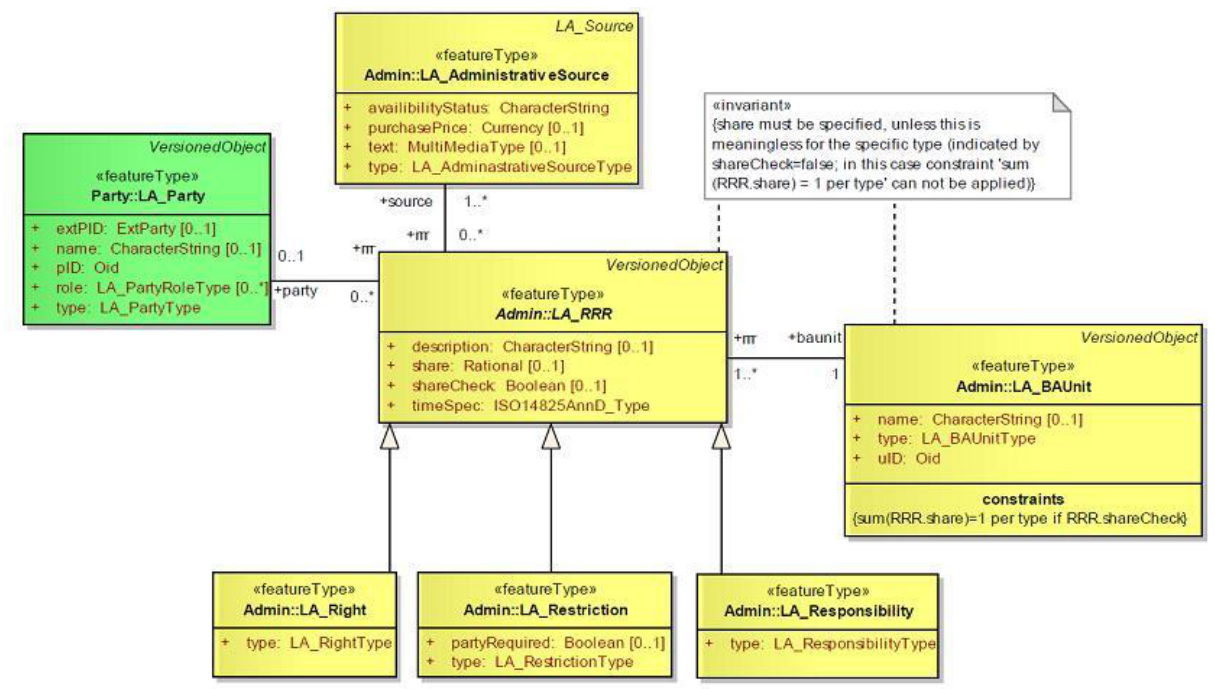
own, to do something, or to refrain from doing